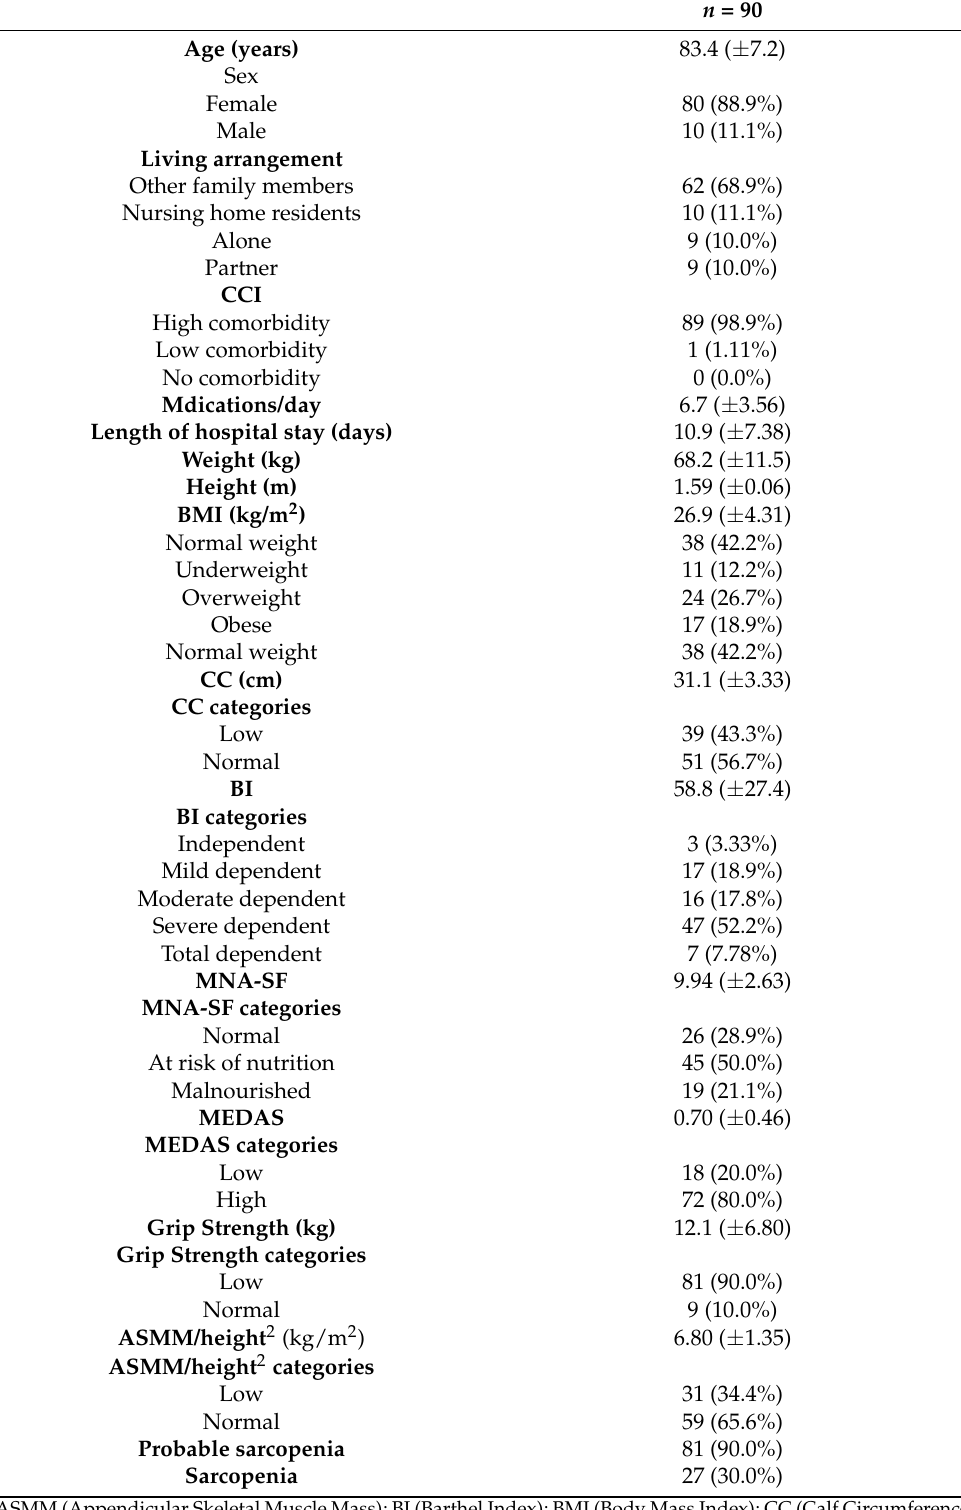
Table 1. General characteristics of the study sample (90 older patients with hip